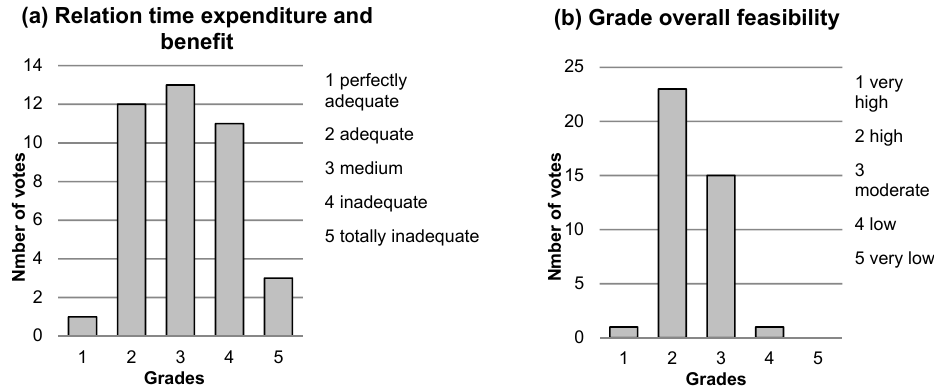
Figure 4. ( a ) Relation between time expenditure and benefit of applying the KTBL guide and ( b ) overall feasbility of the KTBL recommendations evaluated by 40 fattening pig farmers on five-point rating scales.